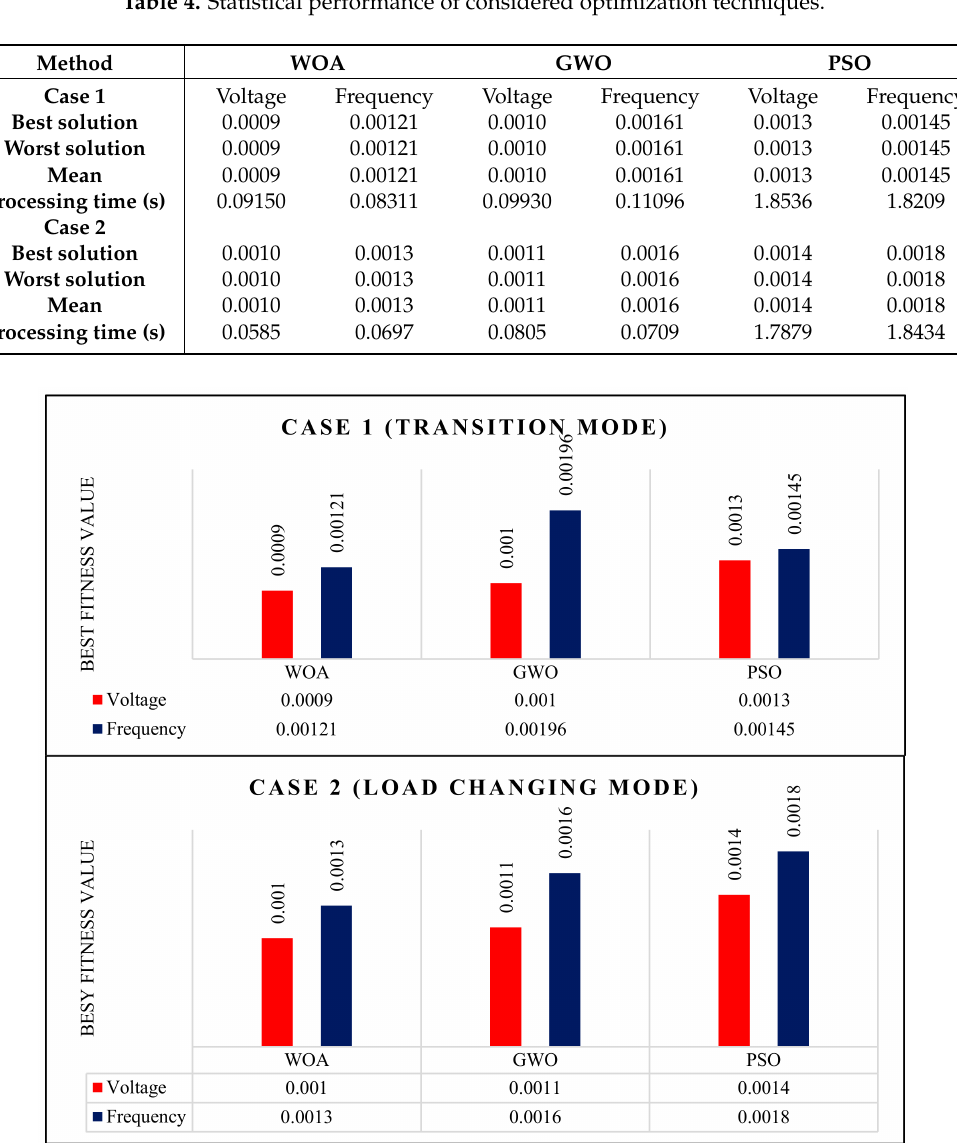
Figure 11. Performance index of PI controller with WOA, GWO and